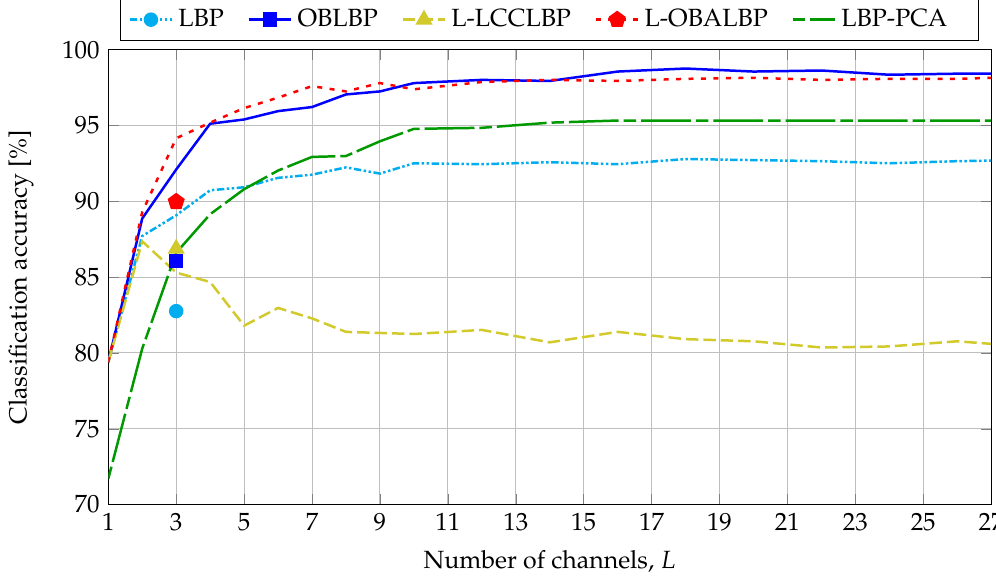
Figure 16. Classification accuracy reached by each Local Binary Pattern (LBP) descriptor with respect to the number of channels, L . LBP [73] (Equation (11)), Opponent Band LBP (OBLBP) [76] (Equation (12)), Luminance-Opponent Band Angle LBP (L-LCCLBP) [78] (Equation (15)), L-OBALBP [79] (Equation (16)). LBP-PCA refers to the marginal LBP operator applied to the PCA channels. Classification performances were stabilized after L = 10 channels: about 92% accuracy for LBP, 98% accuracy for OBLBP and L-OBALBP, 81% accuracy for L-LCCLBP and 95% accuracy for LBP-PCA. The best performance was given by OBLBP with a 98.76% accuracy for L = 18 channels. The markers refer to the classification accuracies of the descriptors applied on the L = 3 channels of simulated RGB images from the three spectral sensitivities of the tri-CCD Basler L301kc color camera